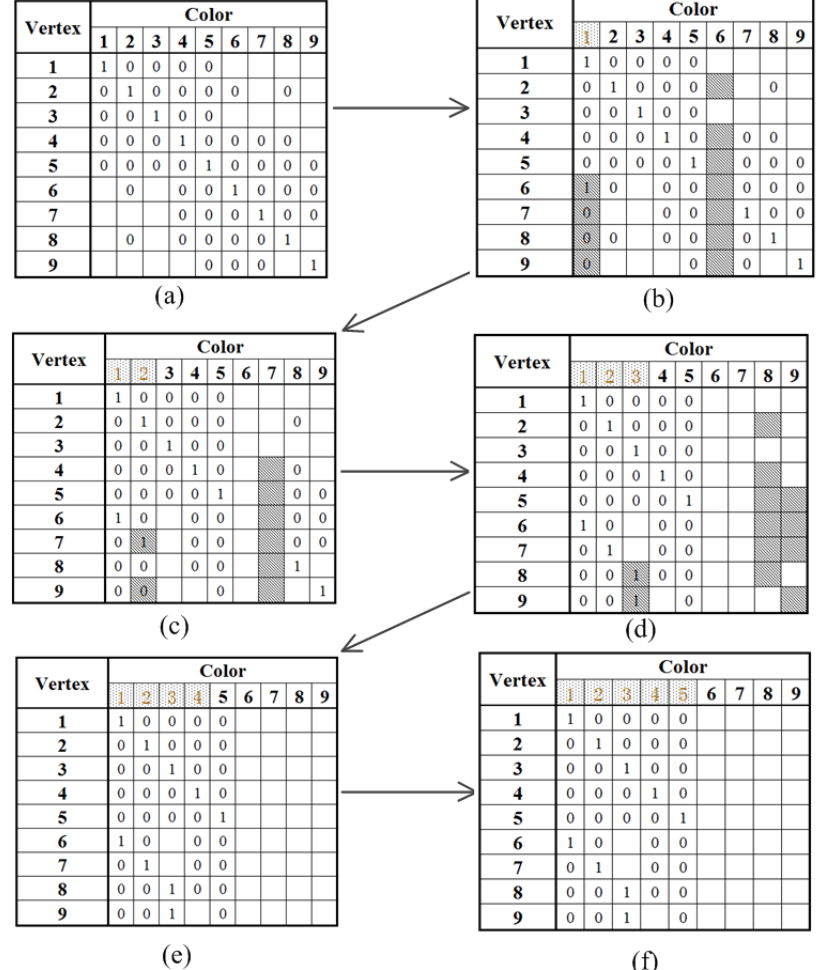
Figure 7. The step-by-step evolution of the allocation matrix. ( a ) depicts the initial allocation matrix after building up the neighbor map for every antenna. ( b ) shows vertices 1 and 6 are assigned with time slot 1. Time slot 6 is released. Time slot 1 is no longer available for vertices 7, 8, and 9. ( c – f ) demonstrate the assignment of time slots 2 to 5 among these